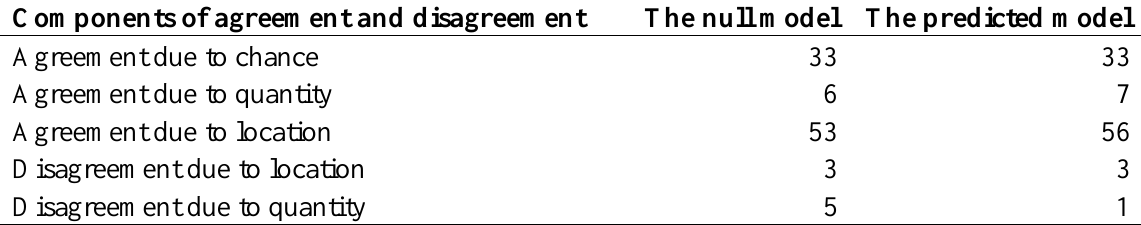
Table 3. Agreement and disagreement of the null and predicted models at 30-meter resolution (percent of the